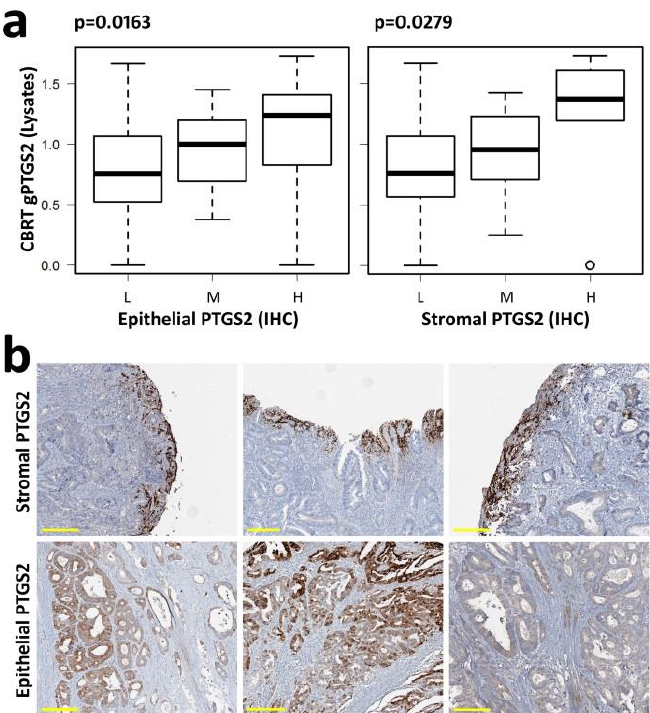
Figure 2. gPTGS2 is expressed in tumor stroma and tumor epithelial cells: ( a ) gPTGS2 levels, quantified in 100 CRC lysates by WB, show a directly proportional correlation with both epithelial and stromal PTGS2 scored by IHC (L = low, M = intermediate, H = high PTGS2 expression); ( b ) PTGS2 positive stromal cells show a bright staining and localize close to the outer mucosal layer of the tumor (upper row), suggesting a protective, barrier function. Tumor epithelial positivity can be observed in all tumor areas, with variable intensity of staining and localization (lower row). Yellow scale bar = 200 µm.